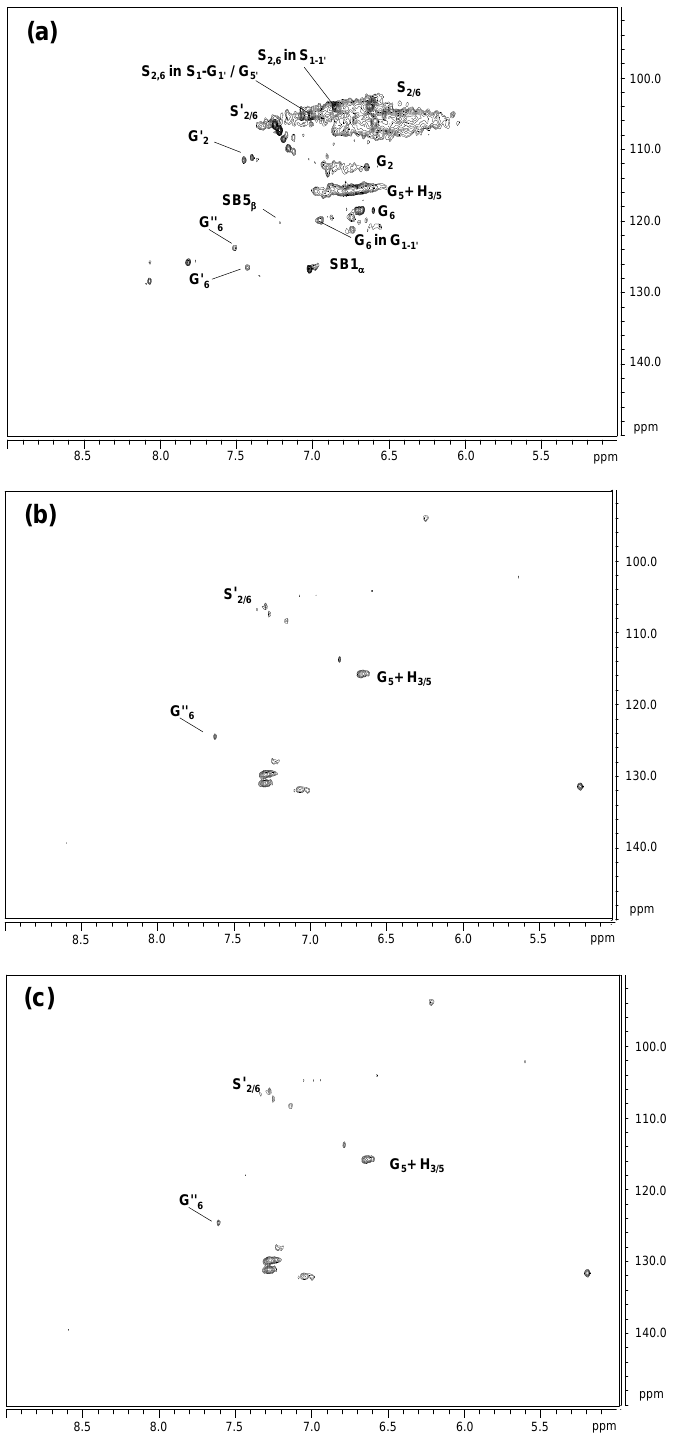
Figure 8. HSQC 2D-NMR spectra, δ C / δ H 90.0–150.0/5.0–9.0 ppm aromatic region, of the untreated lignin ( a ) and of the resulting treated lignins with MtL ( b ) and SiLA ( c ) laccases. Correspondences between lignin structures and assigned letters in the figure: G, guaiacyl unit; G (cid:48) , vanillin; G”, acetovanillona; H, p -hydroxyphenyl unit; S, syringyl unit; S (cid:48) , syringaldehyde (R=H) or acetosyringone (R=CH 3 ); S 1–1 (cid:48) , 3,5-tetramethoxy-para-diphenol; G 1–1 (cid:48) , 3-dimethoxy-para-diphenol; S 1 -G 1 (cid:48) /G 5 (cid:48) ; SB1, stilbene- β -1 (cid:48) ; SB5, stilbene- β -5 (cid:48)